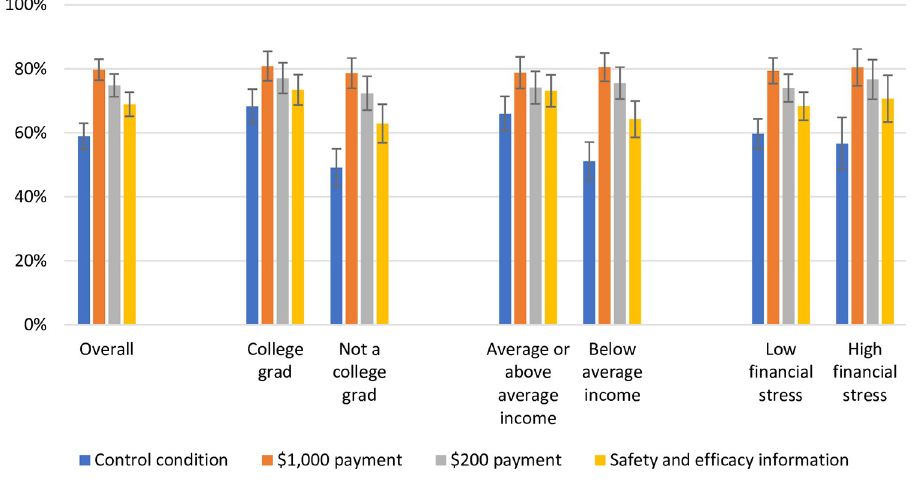
Fig 2. The percentage wanting the COVID-19 vaccine by socioeconomic